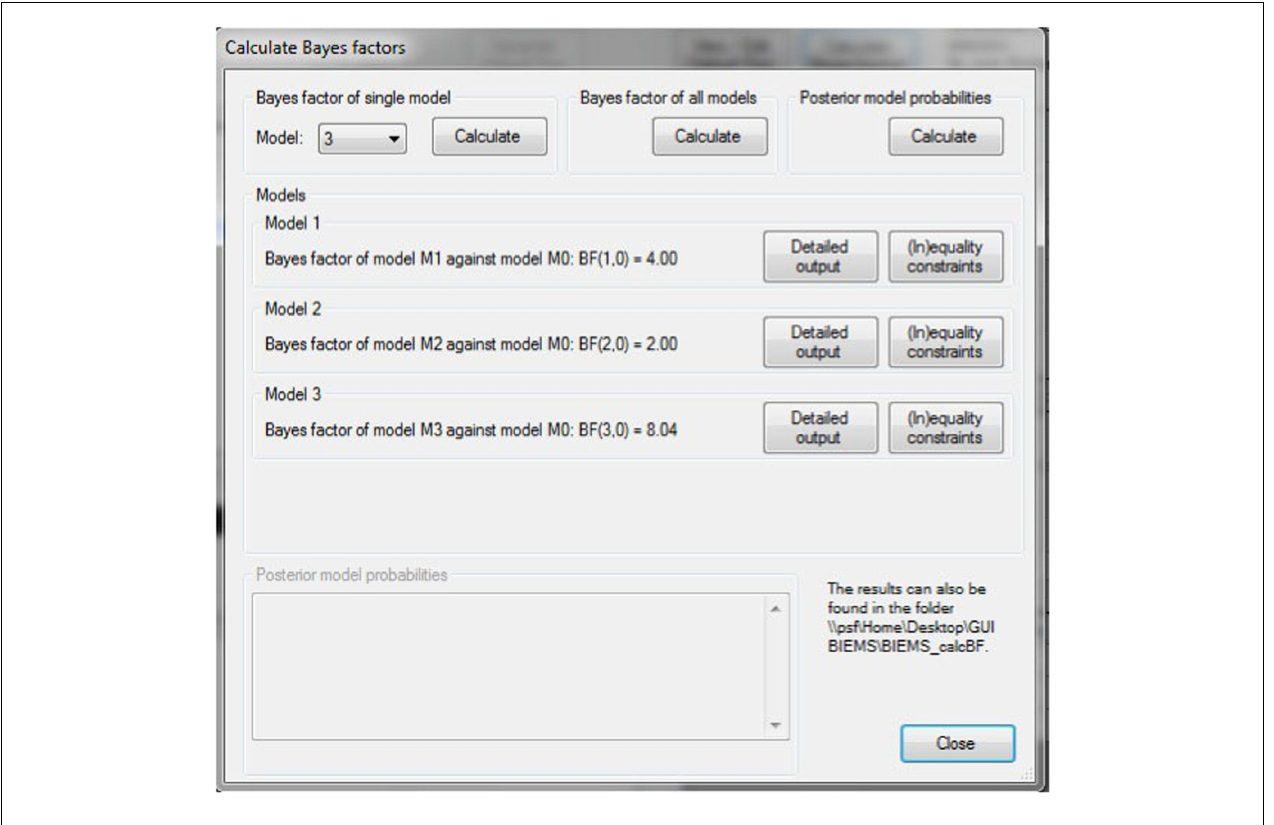
FIGURE 4 | BIEMS output